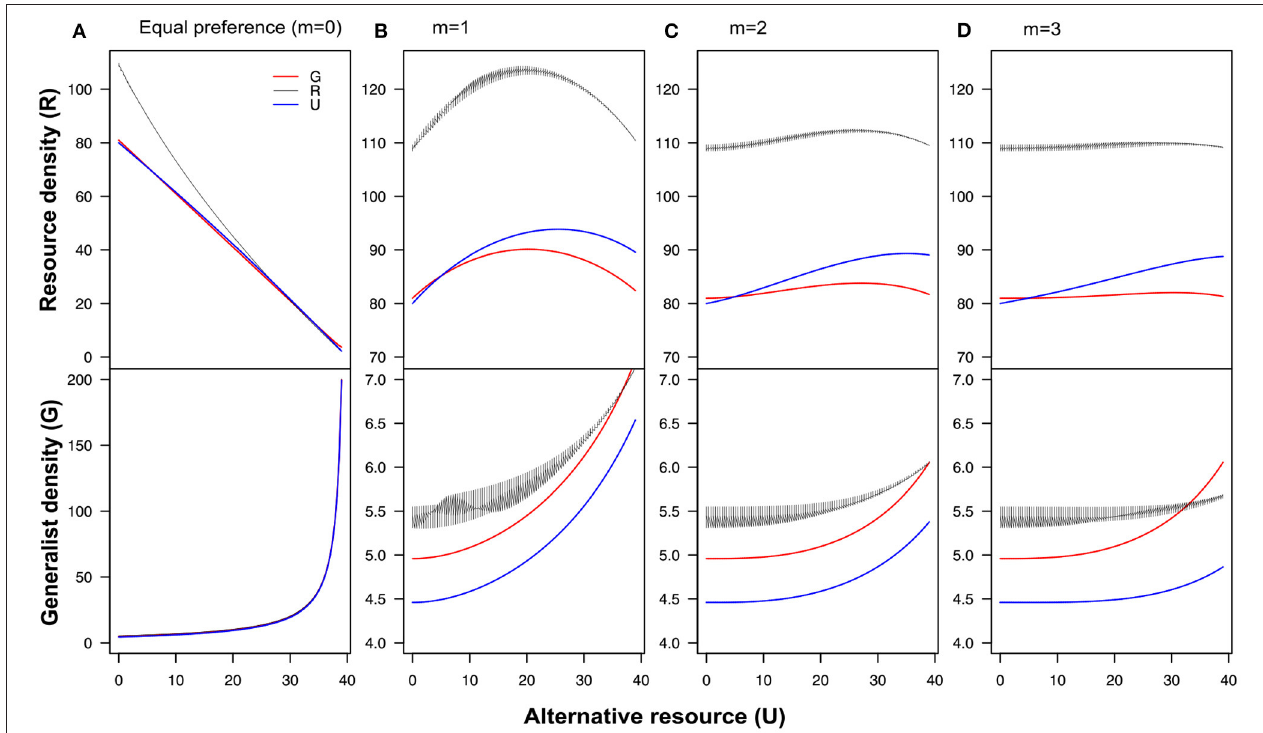
FIGURE 5 | The equilibrium densities of the focal resource and the generalist plotted against the density of the alternative resource. (A) When the resources are equally preferred over the whole range of relative densities ( m the focal resource (upper panel) and the generalist (lower panel) when α depends on the densities of the generalist consumer α c dependent on the focal resource density α c α c , and q = 0.005 [Other parameters values are: alpha 1 + ae qU